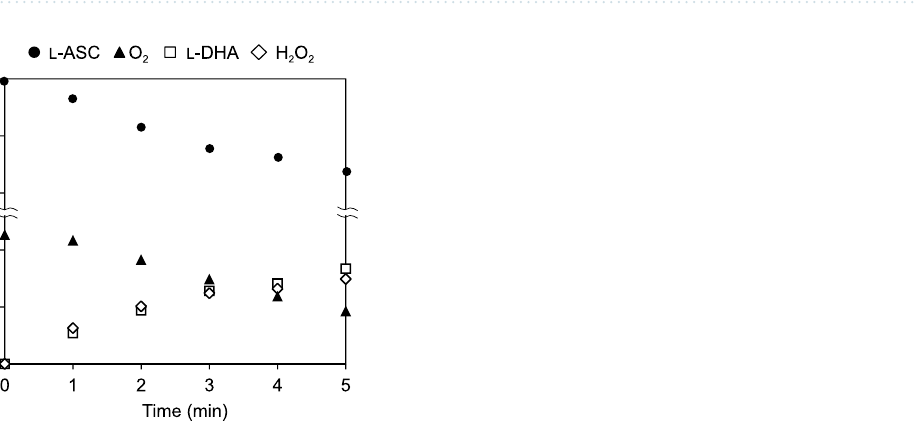
Figure 4. HPLC chromatogram of the reactants. The peaks corresponding to L-ascorbic acid, L-dehydroascorbic acid, and H 2 O 2 before (blue line) and after (red line) the 5 min reaction with granaticin are shown.